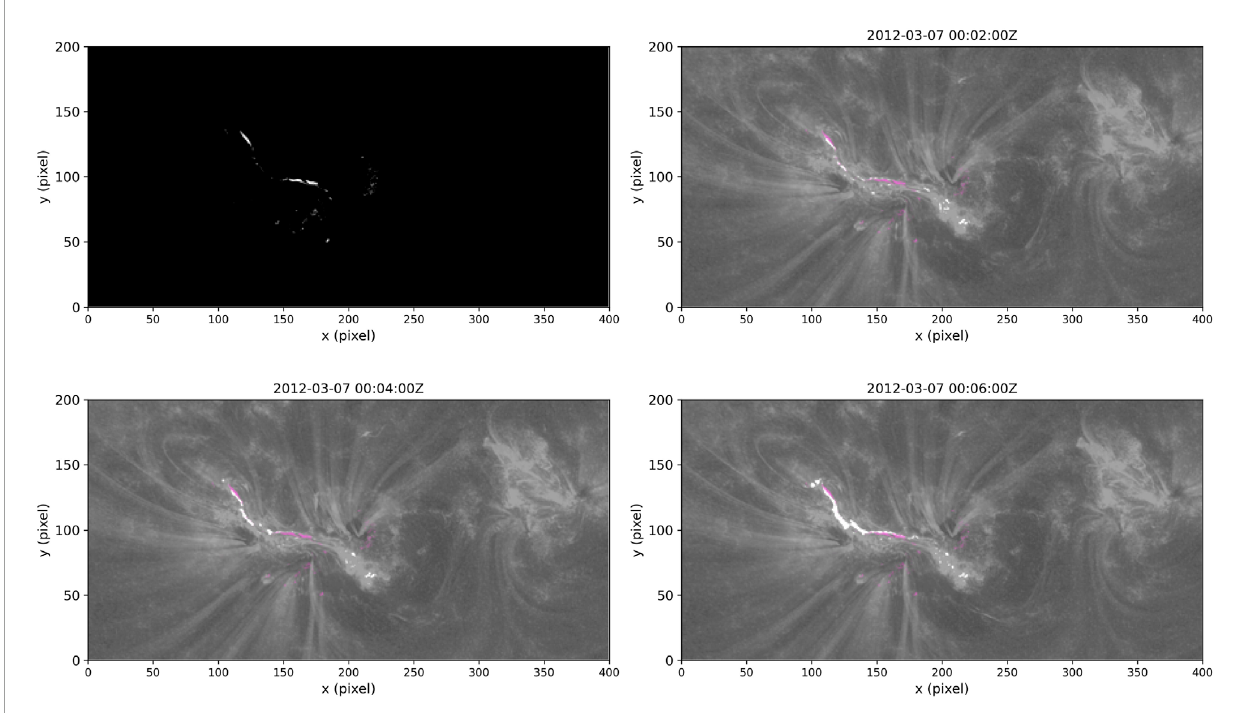
FIGURE 5 (Top Left) The 00:00UT OR defined as region with | B | ≥ 1000 G and | T w | ≥ 1.5 turn within the same boxed in area as before. (Top Right and Bottom) The OR (purple shading) overlaid on the areas of initial flare brightening.